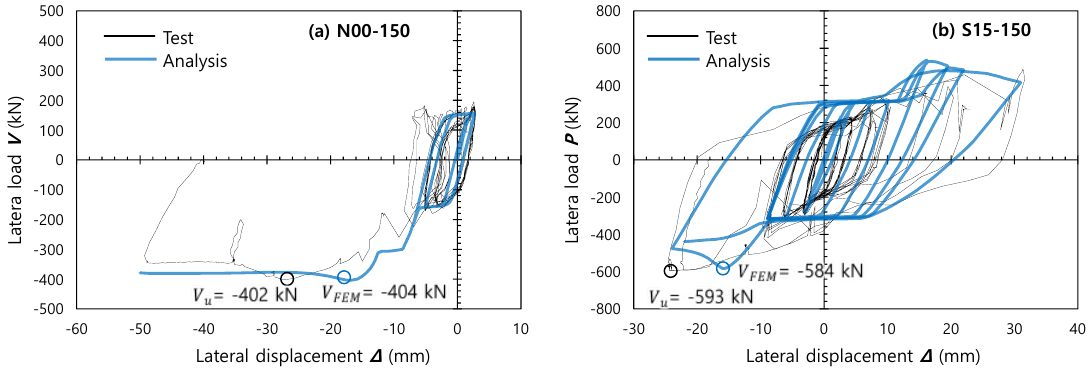
Figure 11. Comparison of load-displacement relationships by finite element modeling (FEM) analysis and test.